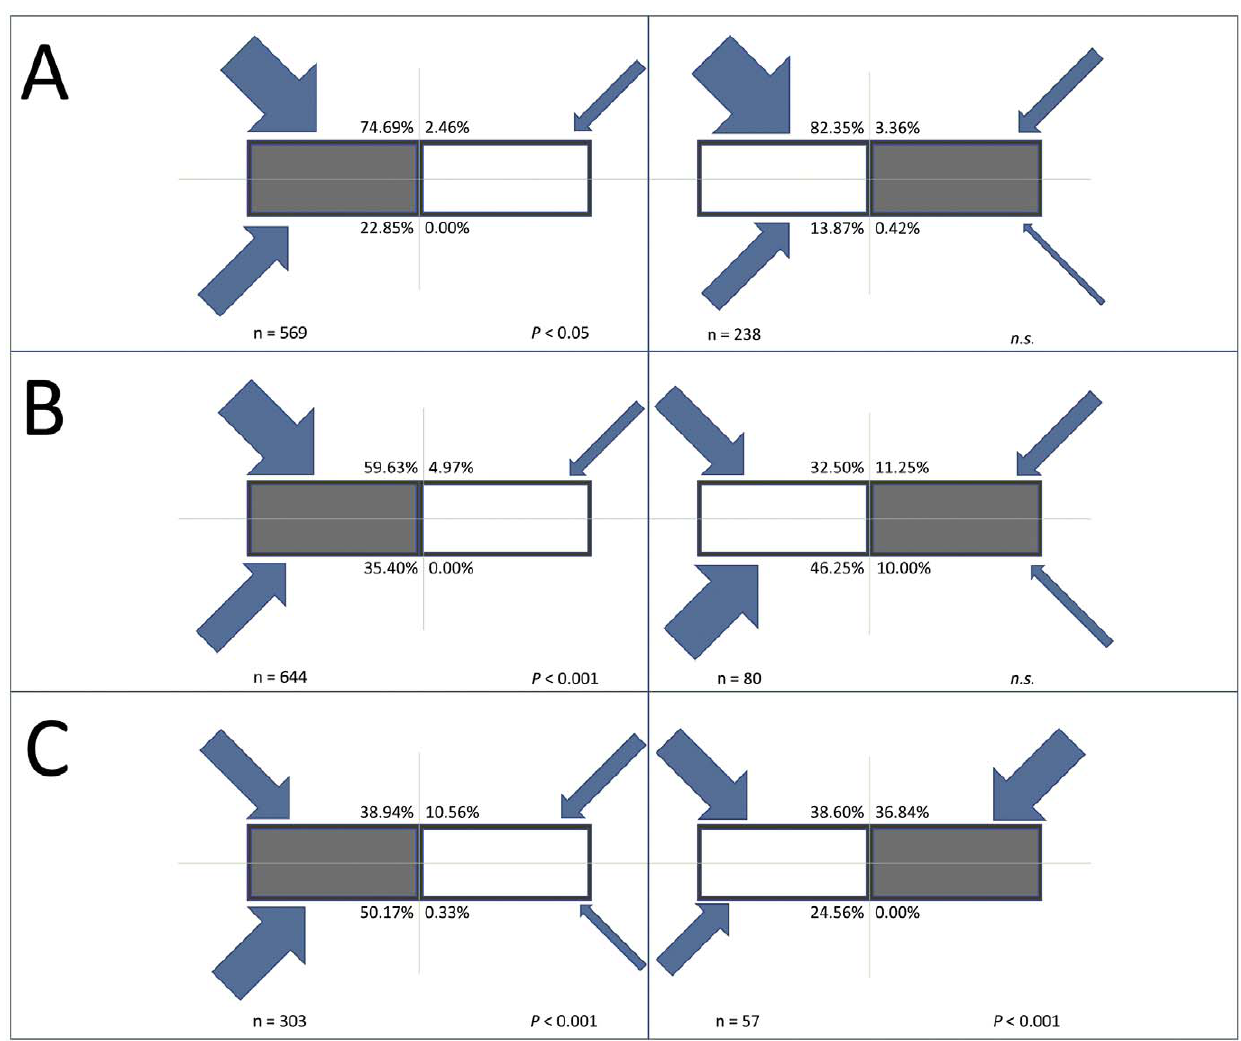
Figure 2. Schematic bird’s eye view of watering troughs manipulated for the experiment at sites A, B and C. For each site one watering trough was covered with Perspex (grey rectangle), the other was left uncovered (white) so that water was available to bats. Two replicates of the experiment were done at each site, covering a different watering trough each time (left and right respectively). The arrows indicate the general direction ( 6 45 u ) from which the bats approached the watering trough for drinking. Arrow width is proportional to the numbers of bats approaching from each direction (percent values are also given). Most bats always came from one side (and, in four out of six cases, one quadrant – see P values of Fisher’s exact tests in figure) and drank at the first watering trough encountered, so that the latter was disproportionately used over the other regardless of whether it had been covered with Perspex or not.